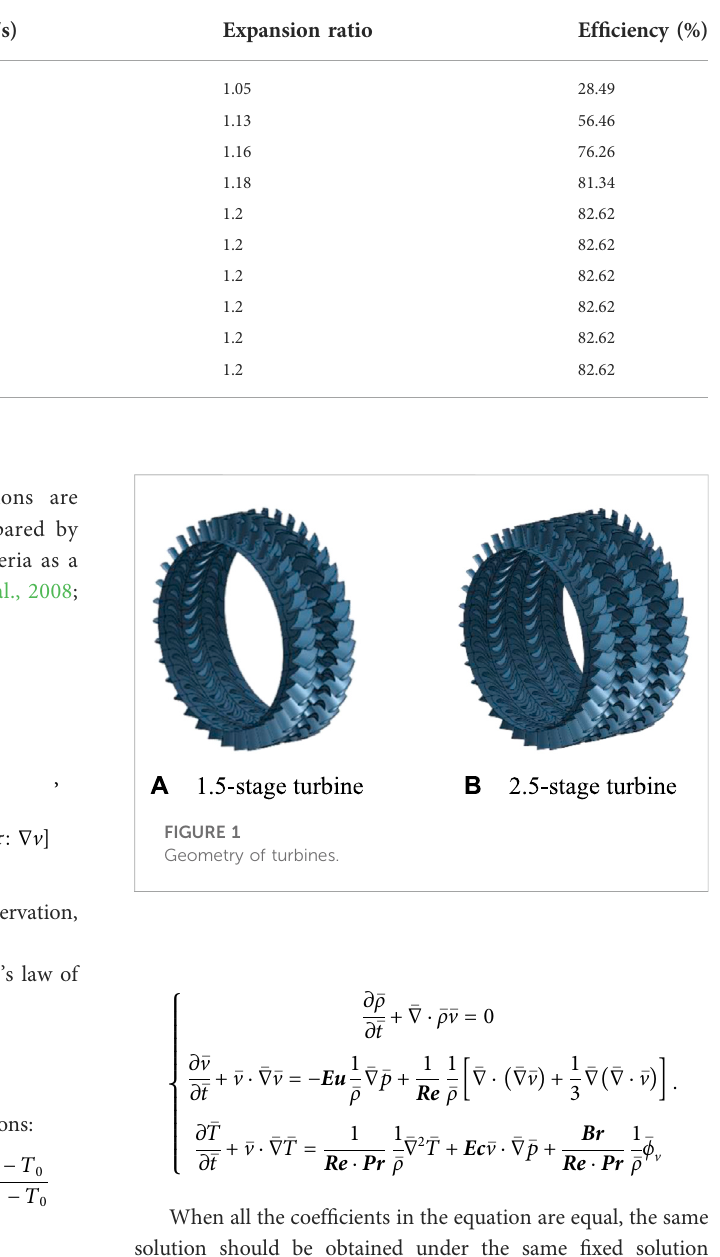
TABLE 1 The Results of the Mesh Independence Study.